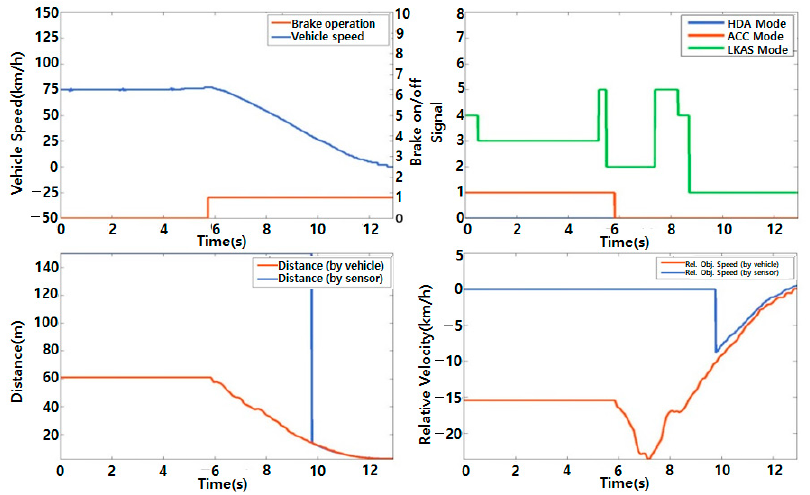
Figure 6. Preliminary data analysis for case 3.